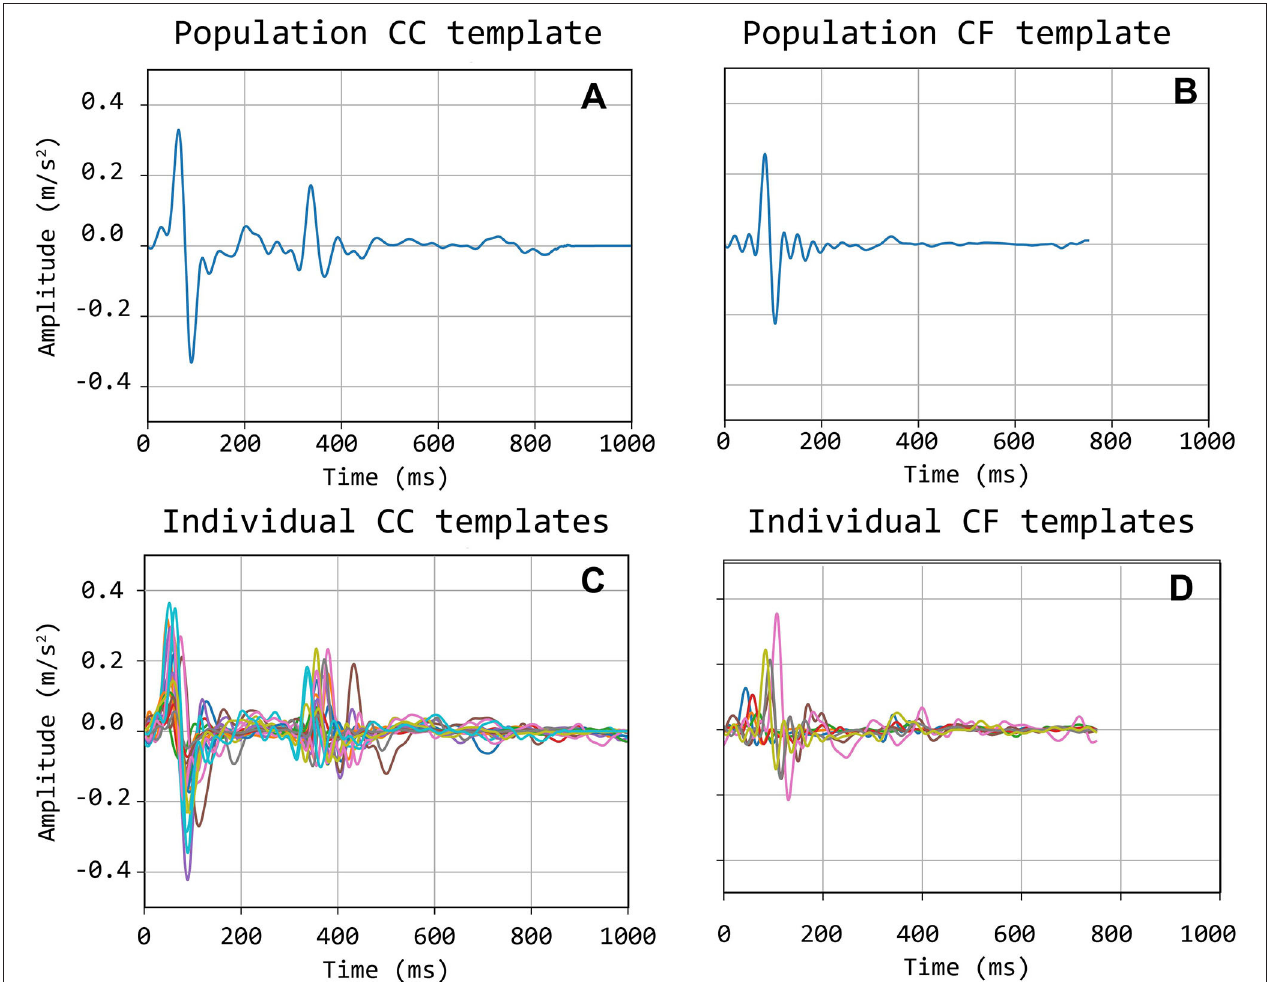
FIGURE 4 | Bottom (C,D) : individual carotid (CC) and femoral (CF) templates; Top (A,B) : population-average carotid and femoral templates.